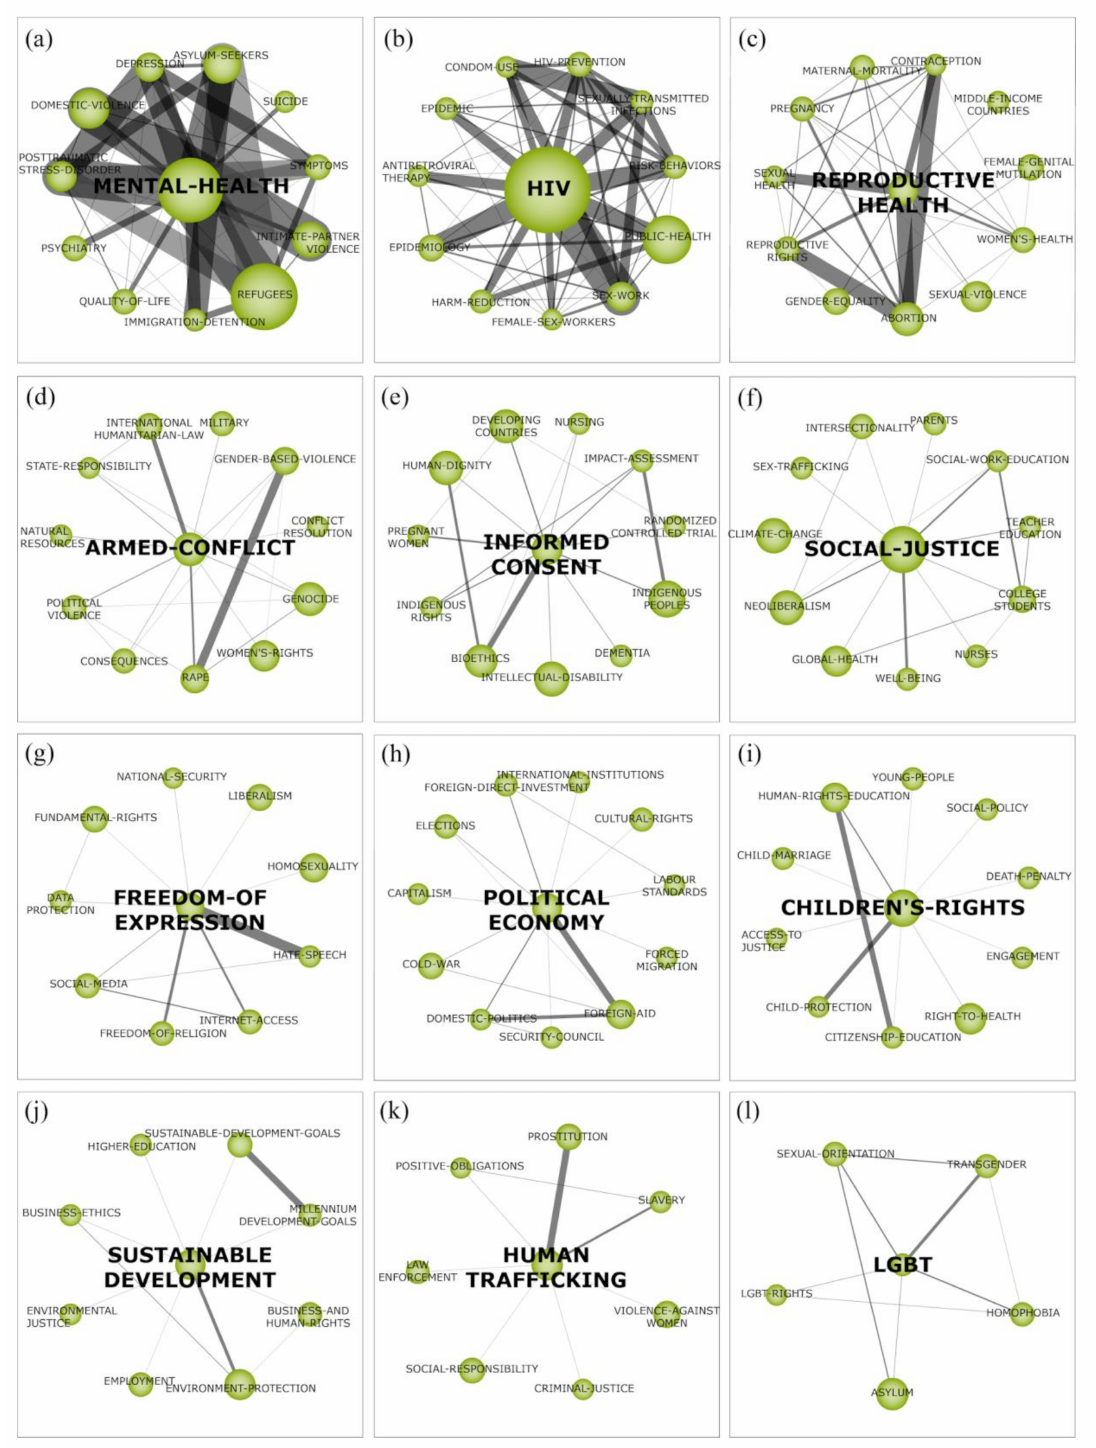
Figure 4. Strategic diagram depicting the performance of human rights research. ( a ) the cluster ‘mental-health’. ( b ) the cluster ‘HIV’. ( c ) the cluster ‘reproductive health. ( d ) the cluster ‘armed-conflict’. ( e ) the cluster ‘informed consent. ( f ) the cluster ‘social-justice’ ( g ) the cluster ‘freedom of expression’. ( h ) the cluster ‘political economy’. ( i ) the cluster ‘children’s rights’ ( j ) the cluster ‘sustainable development’. ( k ) the cluster ‘human trafficking’. ( l ) the cluster